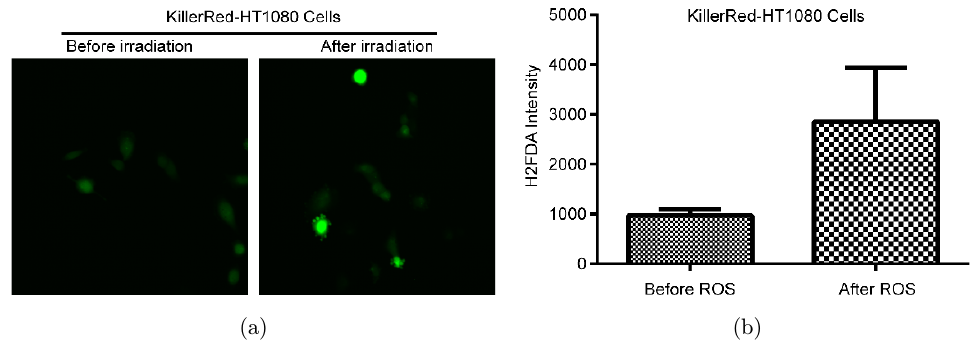
Fig. 1. The image of DCFH-DA stained the HT1080-KillerRed cells under the treatment of the light irradiation. (a) Left panel: The image of DCFH-DA stained the KillerRed-HT1080 cells with no irradiation. Right panel: DCFH-DA stained KillerRed-HT1080 cells under the irradiation for 30 min by 561 nm light. (b) Quantitative analysis from